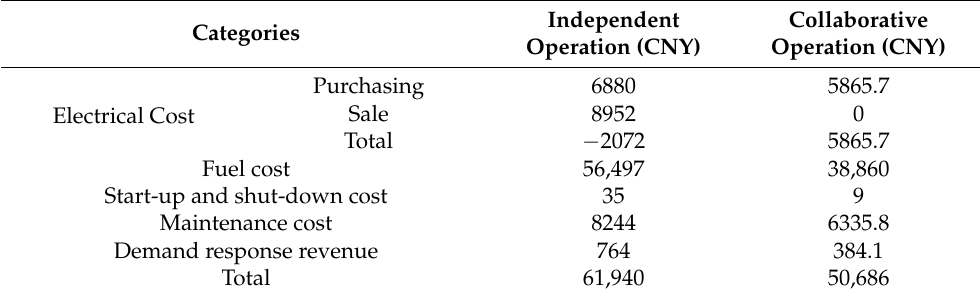
Table 6. The operating results of independent and collaborative optimization